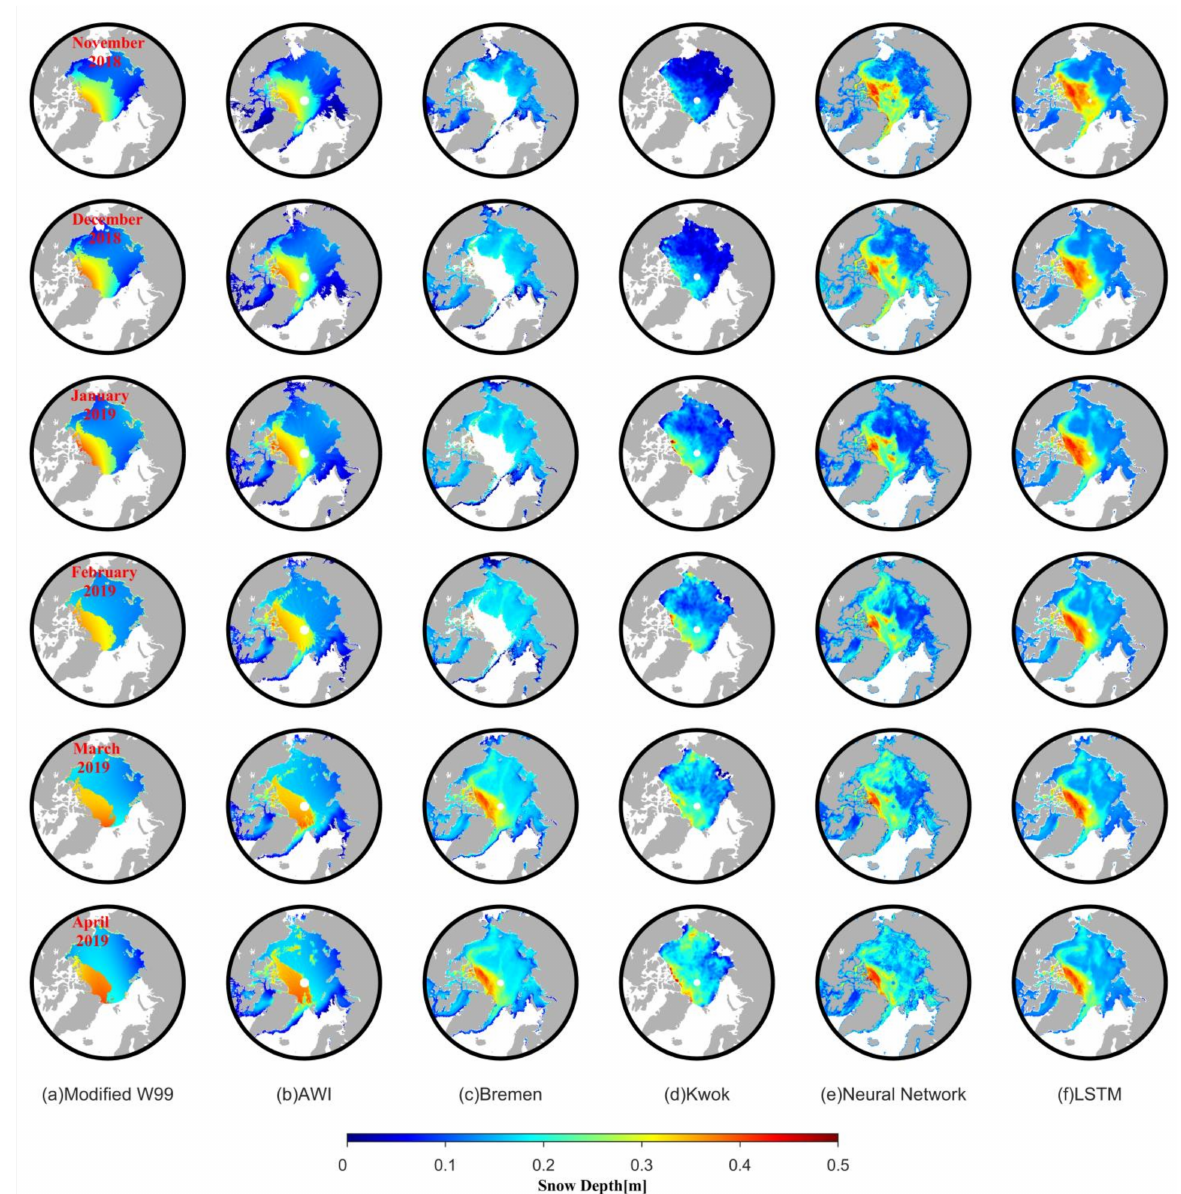
Figure 7. Spatial distribution of different snow depth products: ( a ) modified W99 snow depth, ( f ) LSTM snow depth. The dates from the first row to the last row are November 2018,